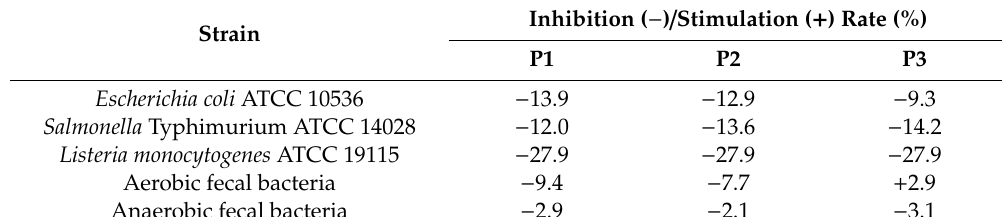
Figure 8. Number of pathogens and fecal isolates adhered to Caco-2 cells in the presence of and without apple pomace (P1, P2, and P3) ± SD. Data represent mean from four repeats in one experiment. Error bars denote SD. * Results significantly di ff erent from the unexposed control, ANOVA ( p < 0.05). Table 4. Adhesion of pathogens and fecal isolates to Caco-2 cells in the presence of apple pomace preparations (P1, P2, and P3). The inhibition/stimulation rate (%) was calculated according to the equation: (adherence of tested sample × 100% / adherence of control) − 100%.